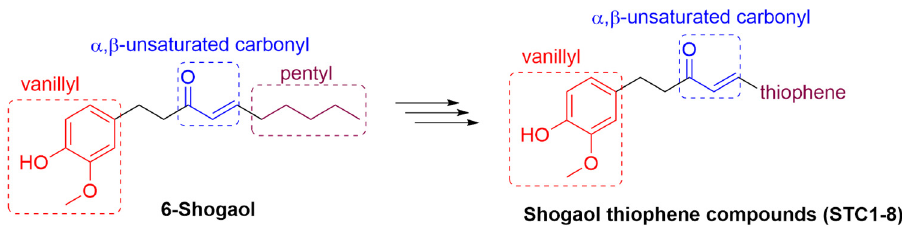
Figure 1. Chemical structure of 6-shogaol and design of shogaol-thiophene compounds (STCs).